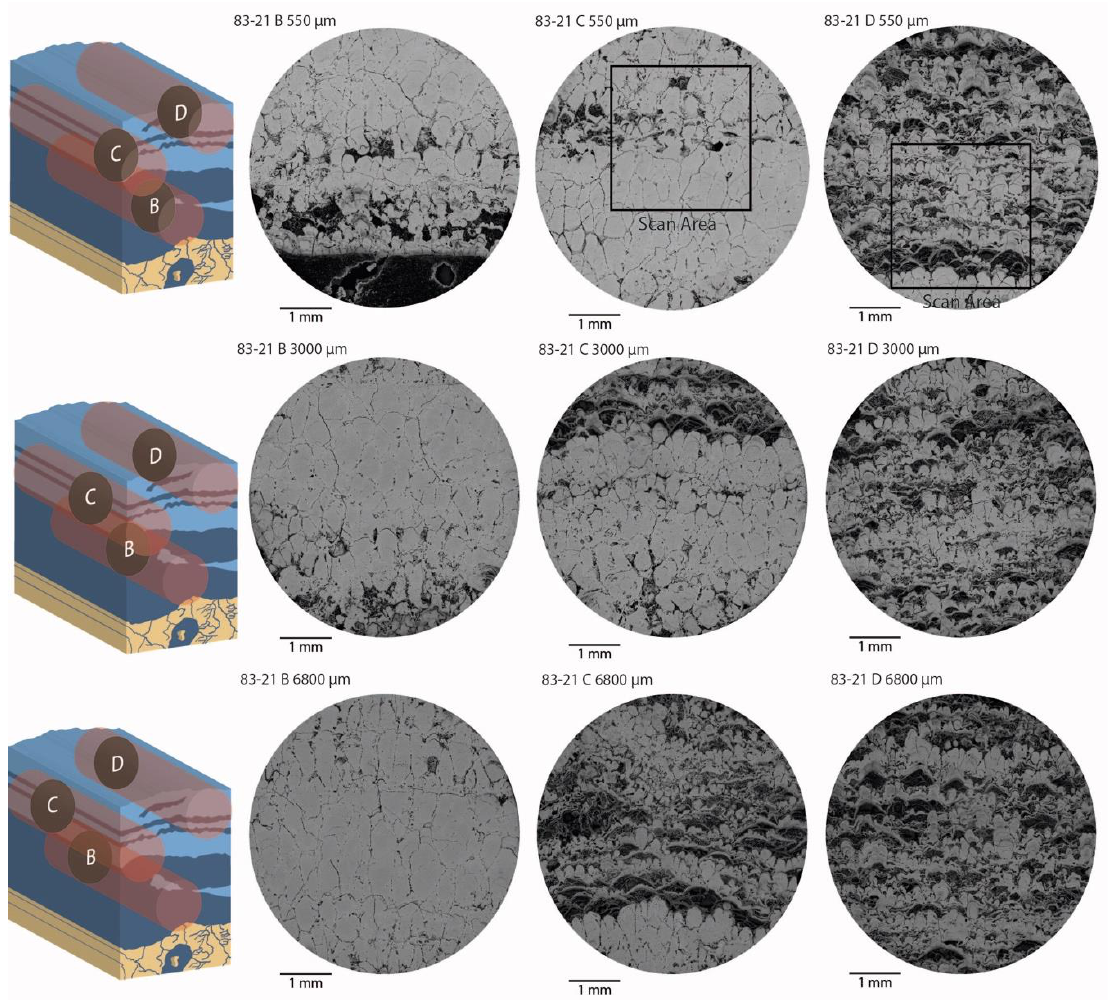
Figure 4. Cross sections through all cores 83-21 B, C, and D made using the SEM. All cores are 4 mm across. The black squares on 83-21 C and 83-21 D show the areas used to measure bulk composition using SEM energy dispersive X-ray spectroscopy (SEM-EDS). Again, good examples of pillared and cuspate textures are visible, as well as erosional (83-21 B 3000 µ m) and gradational (83-21 C 6800 µ m) contacts between them. The block diagrams show their position relative to the sample and each other.